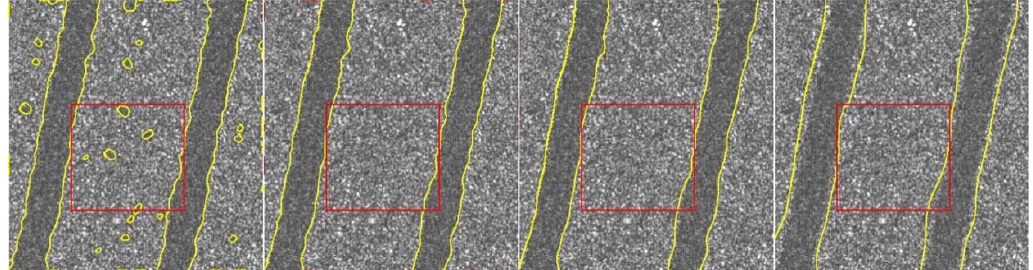
Figure 10. The segmentation results with the change of σ . From left to right: σ = 2,4,10 and 12, respectively. The red square is the initial contours.